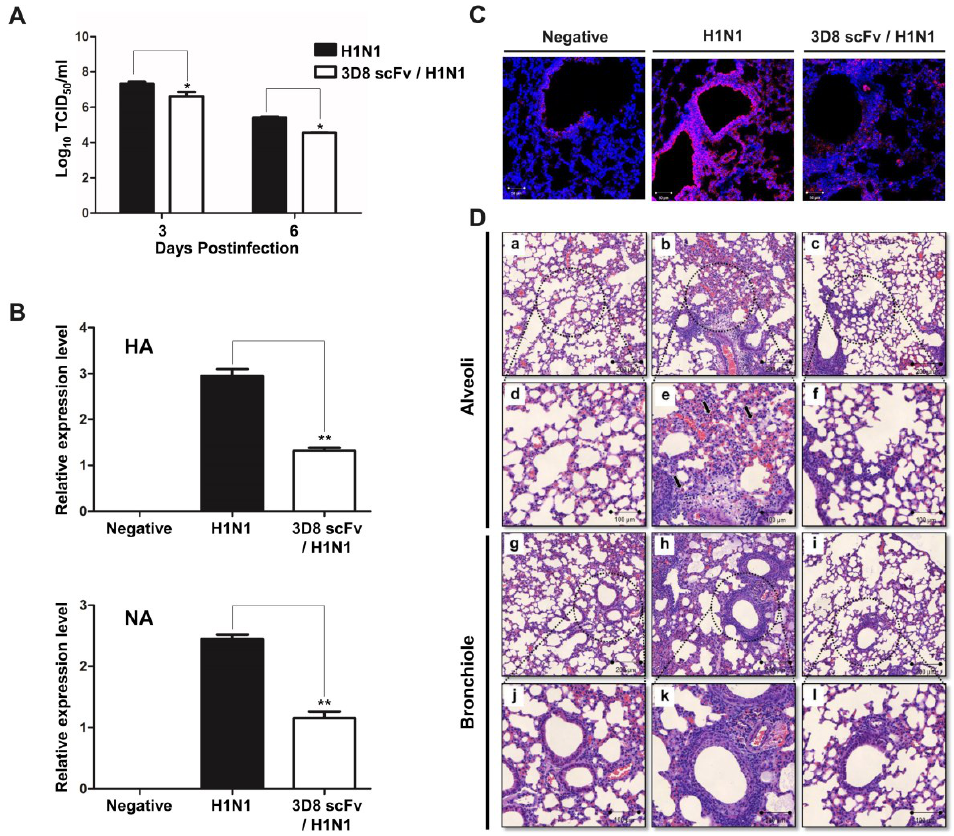
Figure 3. Preventative antiviral effects of 3D8 scFv protein in the lung. Emulsion samples were extracted from lung tissue after virus infection. ( A ) The viral titer was measured by TCID 50 assay; ( B ) Viral replication was analyzed by qRT-PCR; ( C ) To confirm viral protein expression, H1N1 HA protein was detected by confocal microscopy using antibodies specific for HA and GAPDH. Asterisks indicate significant differences ( * p < 0.05, ** p < 0.01) versus the positive (H1N1) control